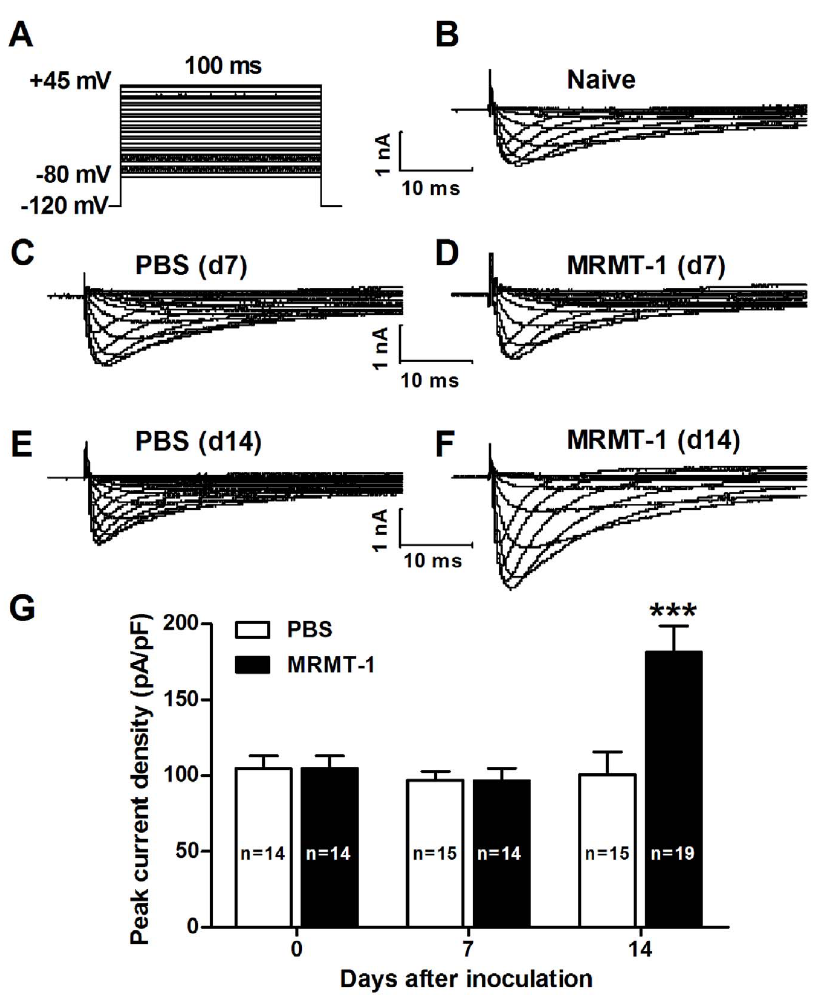
Fig. 1. TTX-R sodium currents recorded on acutely isolated DRG neurons in naı¨ve, PBS-treated and MRMT-1-treated rats. (A): Voltage protocol used for recording TTX-R sodium current with 300 nM TTX in the bath solution. (B to F): Representative traces of TTX-R sodium current in naı¨ve (B), PBS-treated (C and E) and MRMT-1-treated (D and F) rats, recorded on DRG neurons at 7 (C and D) and 14 (E and F) days after the inoculation of tumor cells or PBS. (G): Statistical analysis of the peak current density. Note that the density of TTX-R sodium current is significantly increased in the DRG neurons of bone cancer rats. *** P , 0.001, compared to PBS group, two-way ANOVA, n 5 19 (MRMT-1) and 15 (PBS).